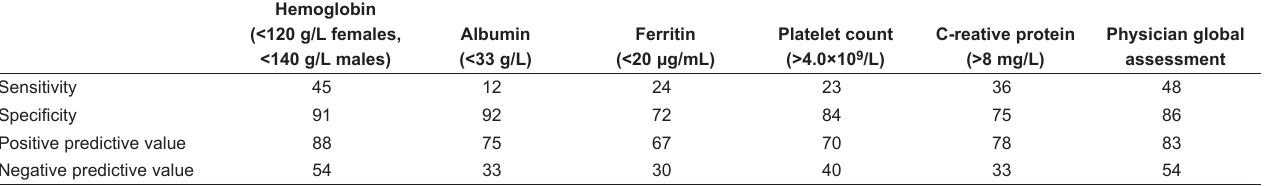
TAble 5 Association of abnormal laboratory data with endoscopy as the gold standard (moderate-severe disease) excluding patients in remission according to physician global